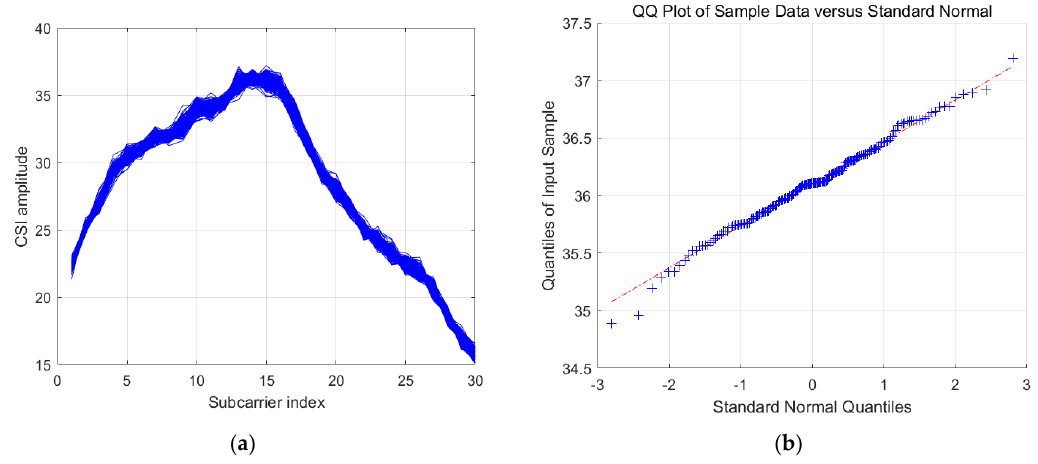
Figure 3. ( a ) The situation where CSI amplitudes form one cluster; ( b ) the QQ-plot of a subcarrier whose amplitudes exhibit an approximately Gaussian distribution.